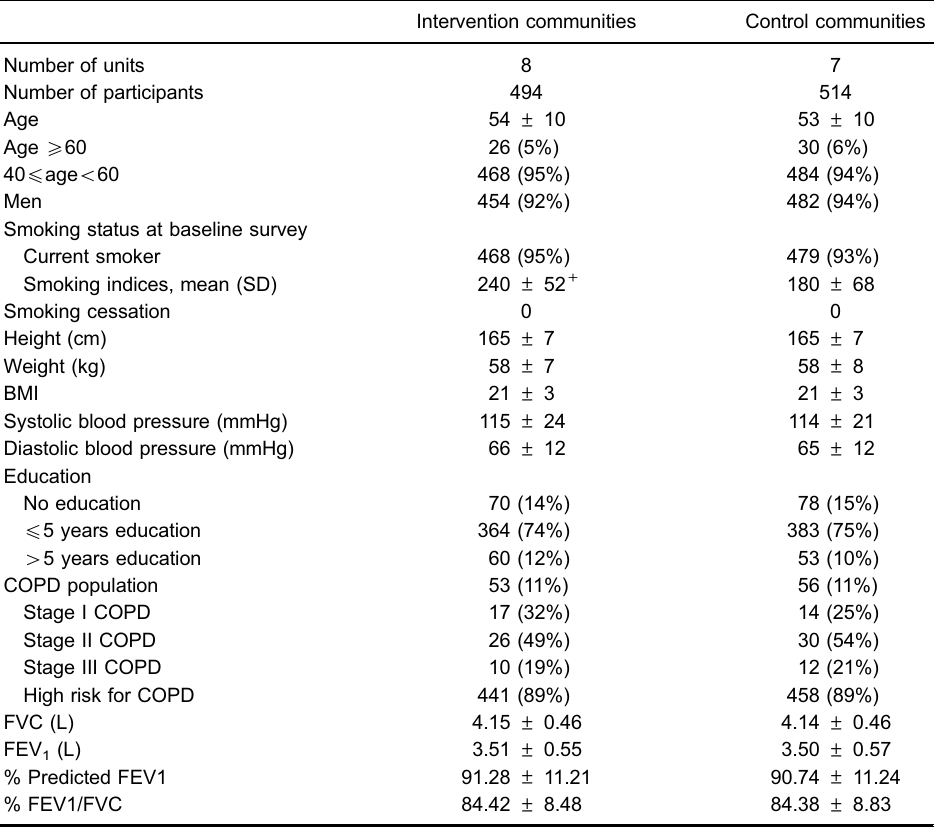
Table 2. Baseline characteristics of the participants who were randomly selected from 15